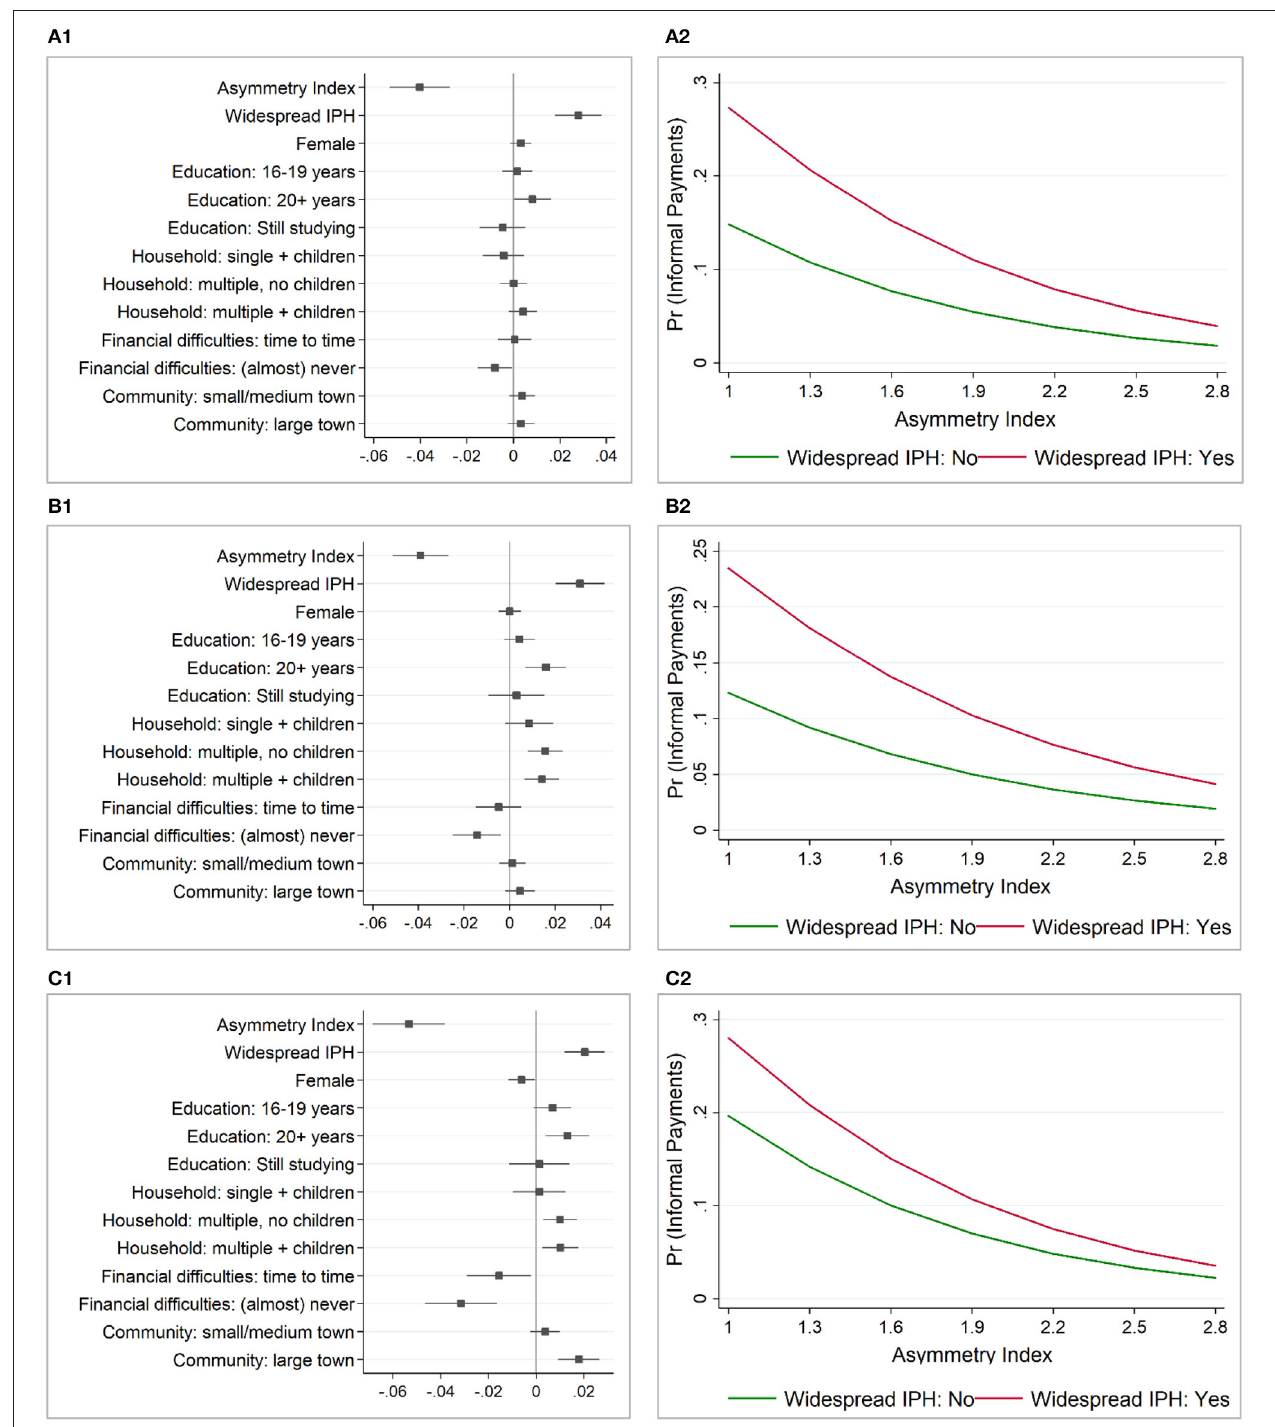
FIGURE 1 | Marginal effects and predicted probability to make informal payments in the EU-27 and the UK. (A1) Marginal effects (2013). (A2) Predicted probability (2013). (B1) Marginal effects (2017). (B2) Predicted probability (2017). (C1) Marginal effects (2019). (C2) Predicted probability (2019). After multilevel logistic regression; Asymmetry Index–norms, values and beliefs (informal institutions) in asymmetry with formal rules (formal institutions); Widespread IPH (Informal Practices in the Healthcare sector)–perception that giving/taking bribes and the abuse of power for personal gain are widespread in the healthcare system; Predicted probability: fixed portion only—by a “representative” patient in EU-27 and UK (mean and mode of the socio-demographic variables: female, 16–19 years when stopped education, having (almost) never difficulties in paying bills and living in a multiple household with children in a small/middle sized town). Source: own calculations based on data from Special EB 397/Wave EB79.1 (2014, fieldwork 2013), Special EB 470/Wave EB88.2 (2017, fieldwork 2017) and Special EB 502/Wave EB92.4 (2020, fieldwork 2019).